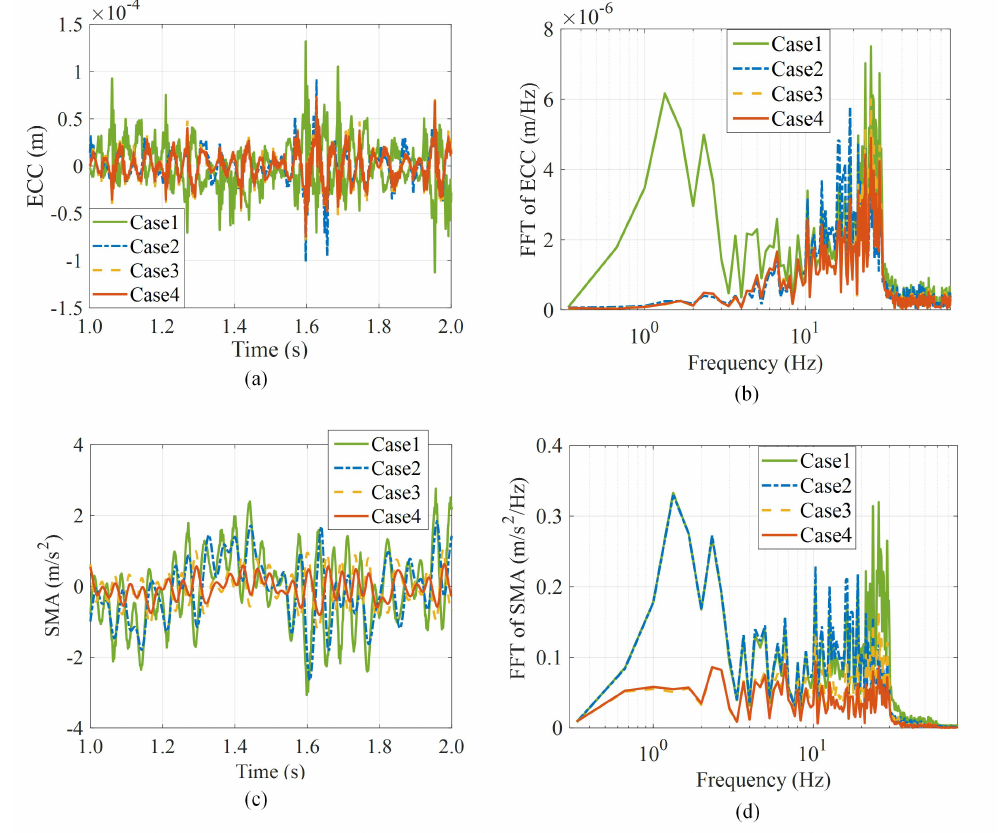
Figure 11. Responses of four cases under the road excitation: ( a ) SMA time response; ( b ) SMA frequency response; ( c ) ECC time response; ( d ) ECC frequency